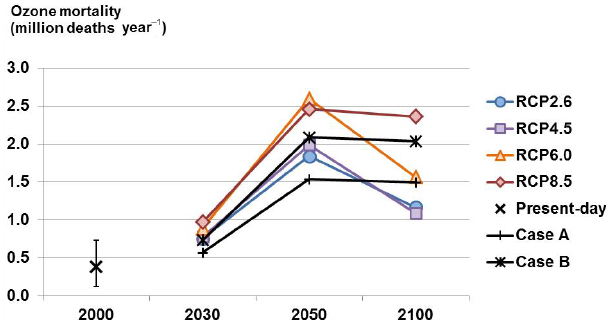
Figure 8. Global burden on mortality of ozone concentrations rel- ative to 1850, in the present day for 2000 concentrations, showing multi-model average and 95% CI including uncertainty in RR and across models (deaths per year), and in 2030, 2050 and 2100 for all RCPs, showing multi-model averages (deaths per year) given by the deterministic values. Also shown are future burdens using (Case A) 2000 concentrations relative to 1850 and present-day population but future baseline mortality rates and (Case B) 2000 concentrations relative to 1850 but future population and baseline mortality